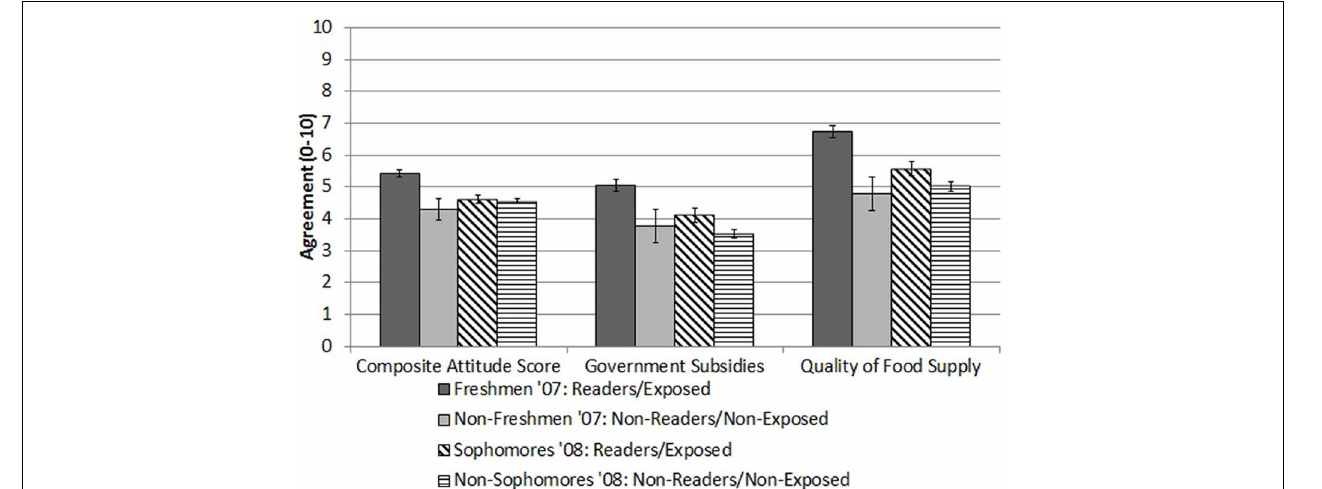
FIGURE 1 | Composite attitude scores and ratings of opposition to government subsidies and belief that the quality of the food supply is decreasing ( M, SE ) in students assigned The Omnivore’s Dilemma